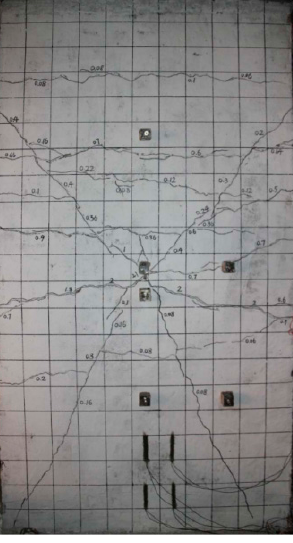
Figure 12. Cracks at the back of the RC shear wall [14]. Copyright 2019, Vibration and Shock.